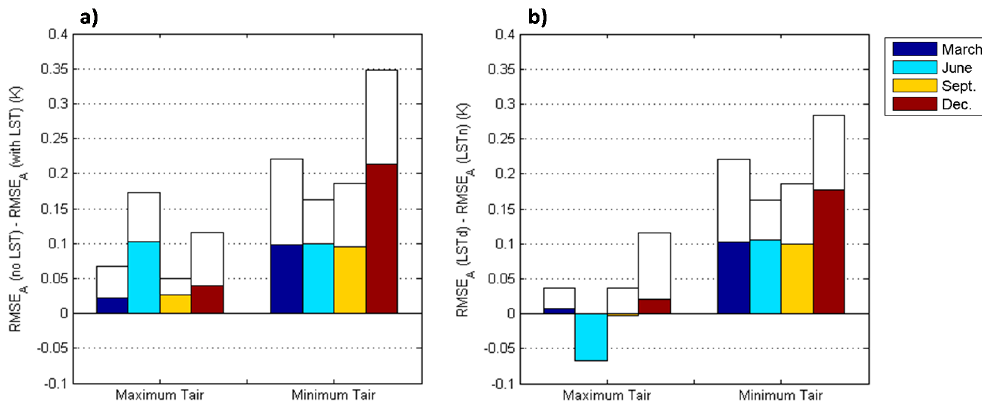
Figure 2. Maximum (white bars) and mean (colored bars) difference in the RMSE A of T air observed after considering the RMSE A obtained during the years 2003–2011 in models with 80 common meteorological stations: ( a ) without or with LST; and ( b ) with daytime or nighttime LST (d and n subscripts, respectively). Remote Sens. 2017 , 9 , 1313